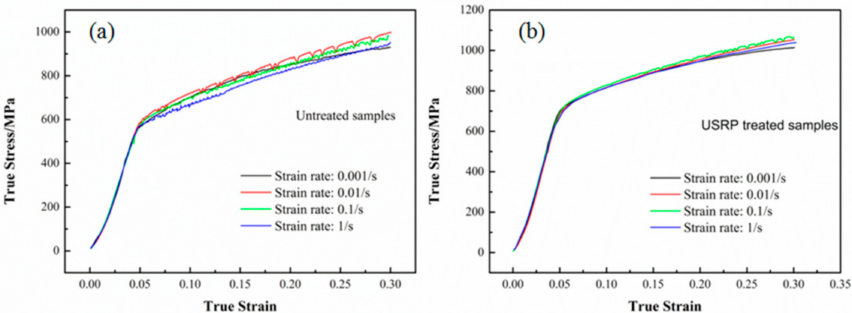
Figure 2. True stress–strain curves of the hot compressed samples under di ff erent strain rates at 700 ◦